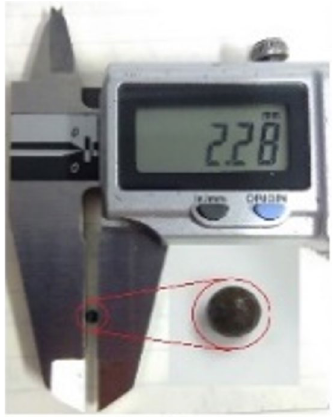
Figure 2. Conductive alginate capsule encapsulating a bitumen rejuvenator oil.